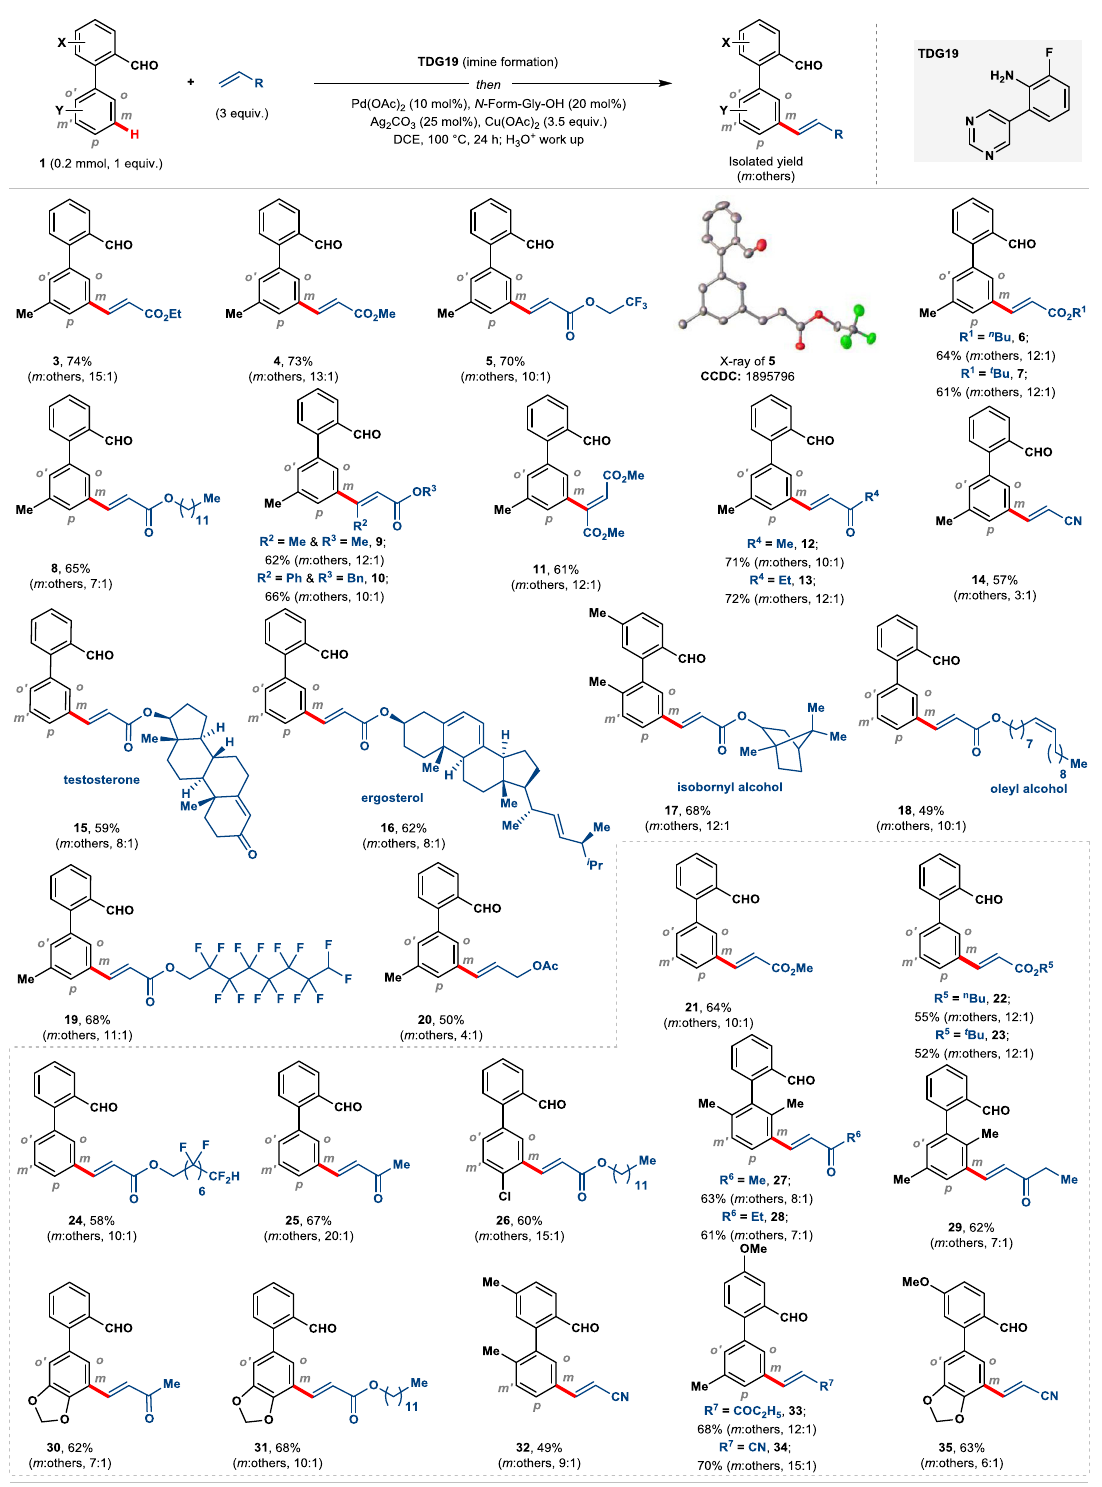
Fig. 3 Scope with a variety of alkenes. Combination of various alkenes and arenes are shown in dotted box. The isolated yields are reported and ratios of meta :others are shown in